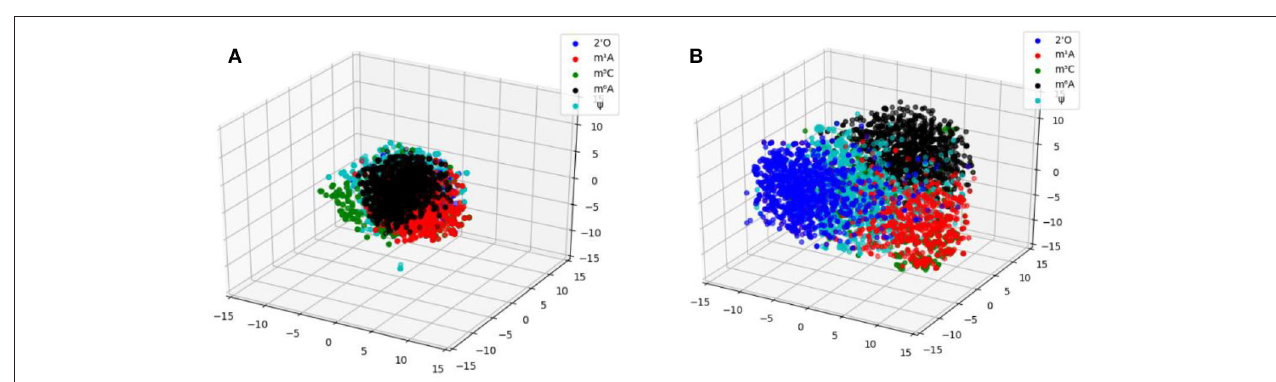
Frontiers in Physics |